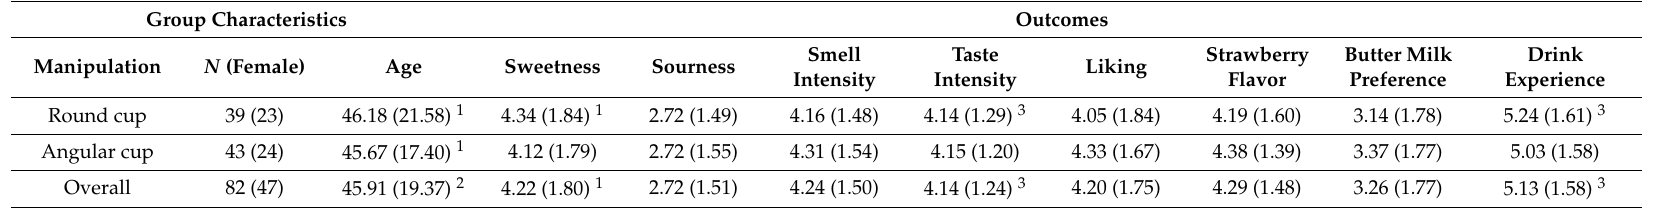
Table 1. Age and gender distributions across groups, and means (standard deviations) for all dependent variables (Study 1). Group